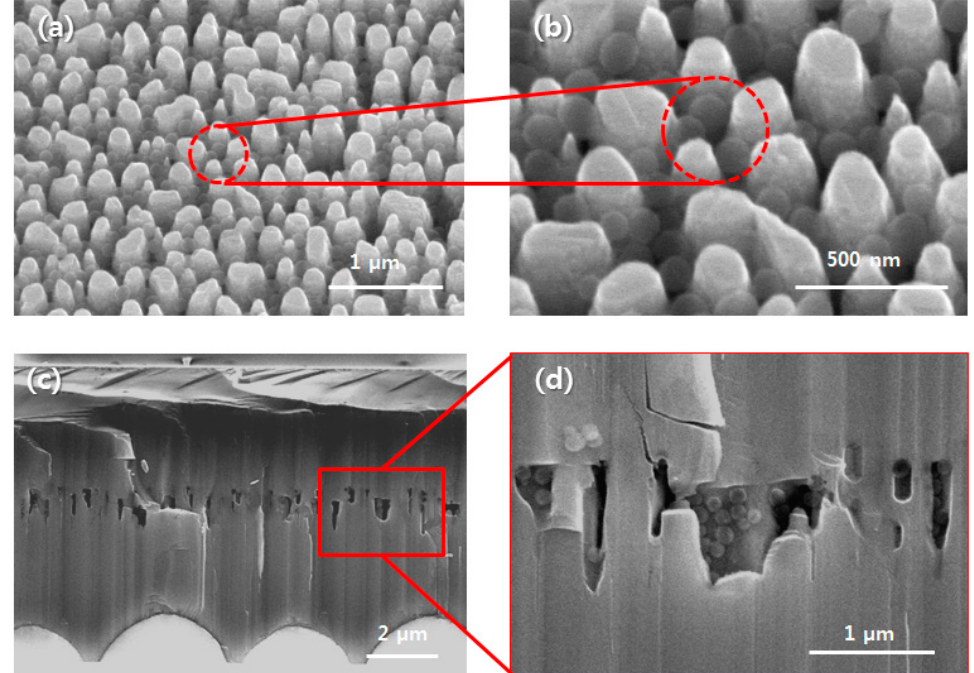
Figure 2. ( a ) Tilted field emission scanning electron microscopy (FE-SEM) image of the SiO 2 nano-particles (NPs) among nano-pillars. ( b ) Zoomed-in image to show the NPs clearly in air-void. ( c ) FE-SEM image of cross-section of the regrown GaN layer with air-voids and nano-pillars. ( d ) Close-up image of cross-section of revealed SiO 2 NPs filling the air-voids on the left.